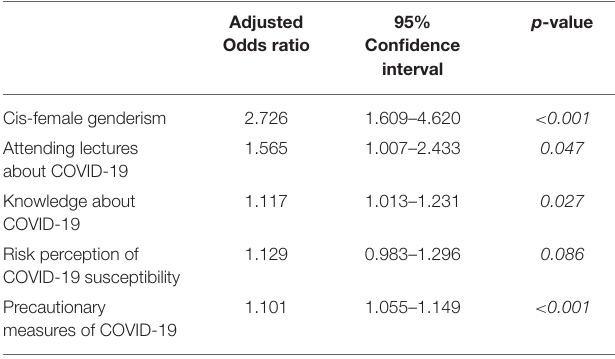
TABLE 5 | The predictors of self-reported obsession by preventive measures of COVID-19 * .